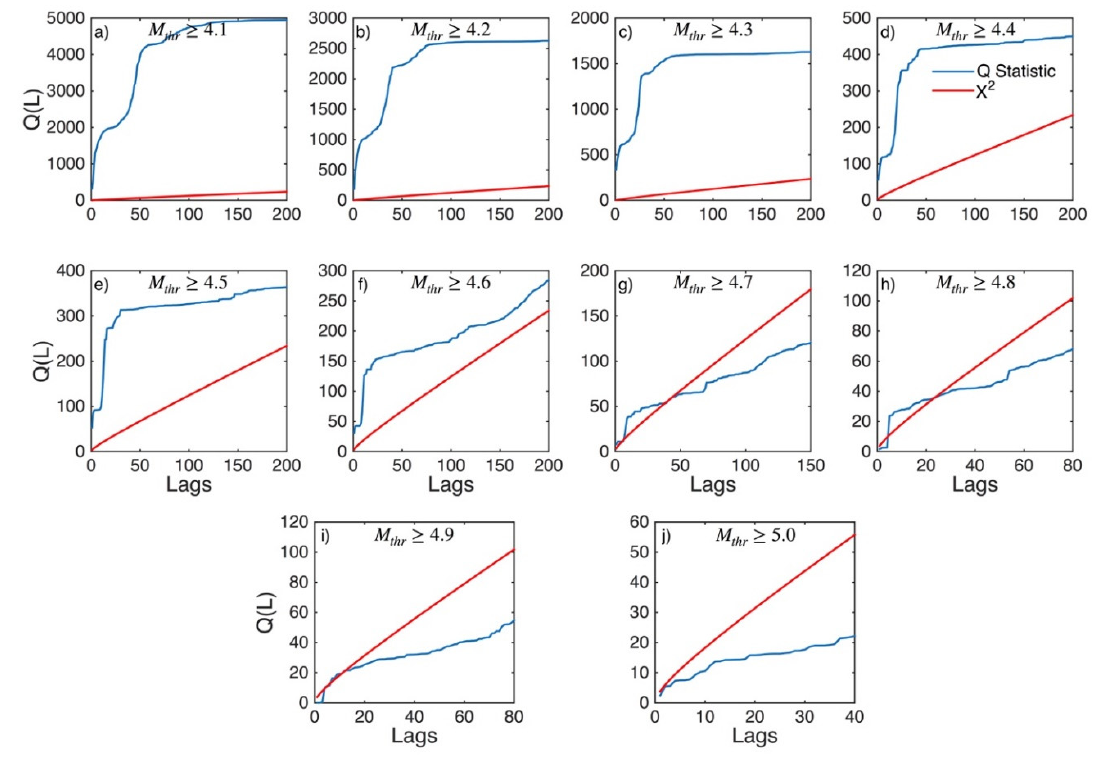
Figure A12. Statistics of Ljung–Box Q-test (blue lines) and the critical values for the X 2 distribution (red lines) for Southeast Aegean Sea (sub-area 5) for magnitude thresholds ( M thr ) varying from 4.1 to 5.0 (subplots a – j ).